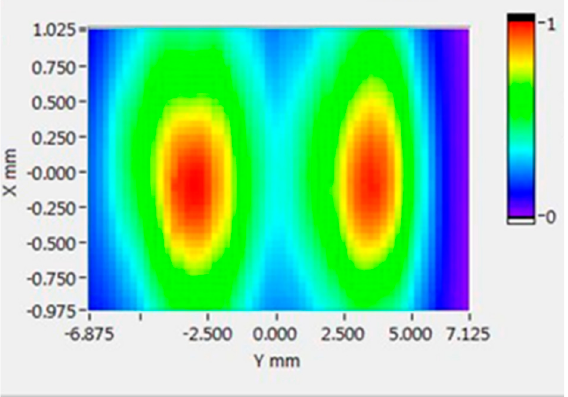
Figure 8. The normalized spatial distribution diagram of the sound field.